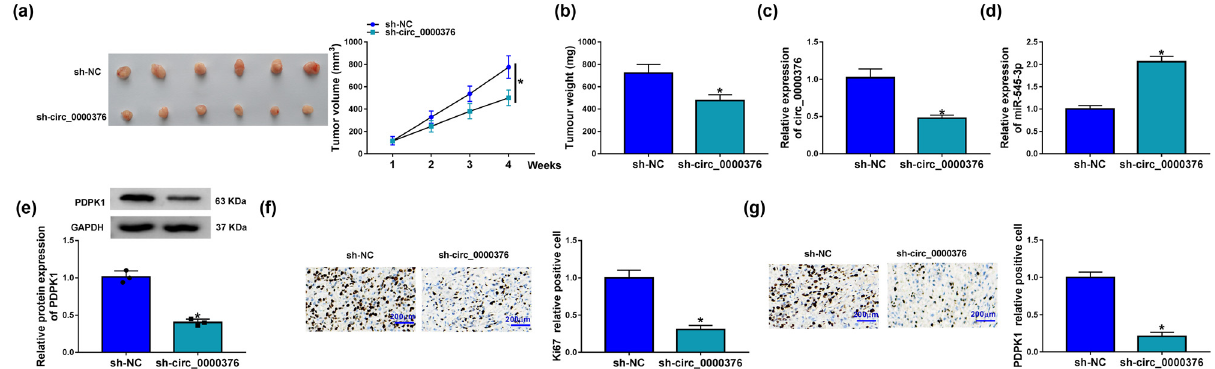
Figure 7: circ_0000376 knockdown inhibited tumor formation. ( a and b ) Impacts of circ_0000376 absence on tumor volume and weight were revealed. ( c and d ) E ff ects of circ_0000376 silencing on the expression of circ_0000376 and miR - 545 - 3p were determined by qRT - PCR in tumor tissues of mice. ( e ) In fl uence of circ_0000376 downregulation on PDPK1 protein expression was analyzed by western blot in the tumor tissues of mice. ( f and g ) Protein expression of Ki67 and PDPK1 was determined by IHC assay. * P <